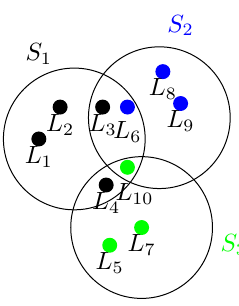
Figure 3. The illustrated scenario where each customer location is assigned exactly to one service